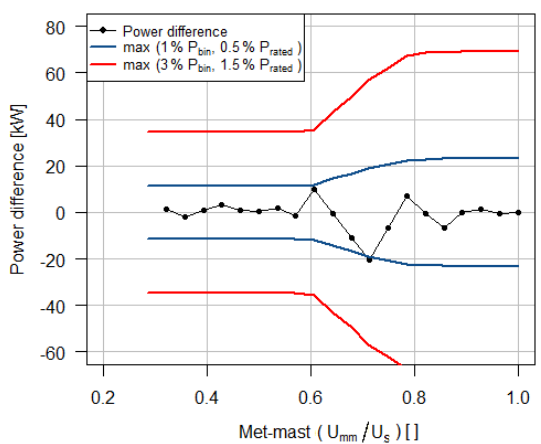
Figure 7. Nacelle transfer function self-consistency check. The black curve shows the power difference between NPC and PC of the wind turbine used to measure the NTF. The NTF passes the test if the black curve is within the boundary marked by the blue curve. If the black curve crosses the red curve a new NTF should be mea- sured. P bin is the averaged power in a wind speed bin. P rated is rated